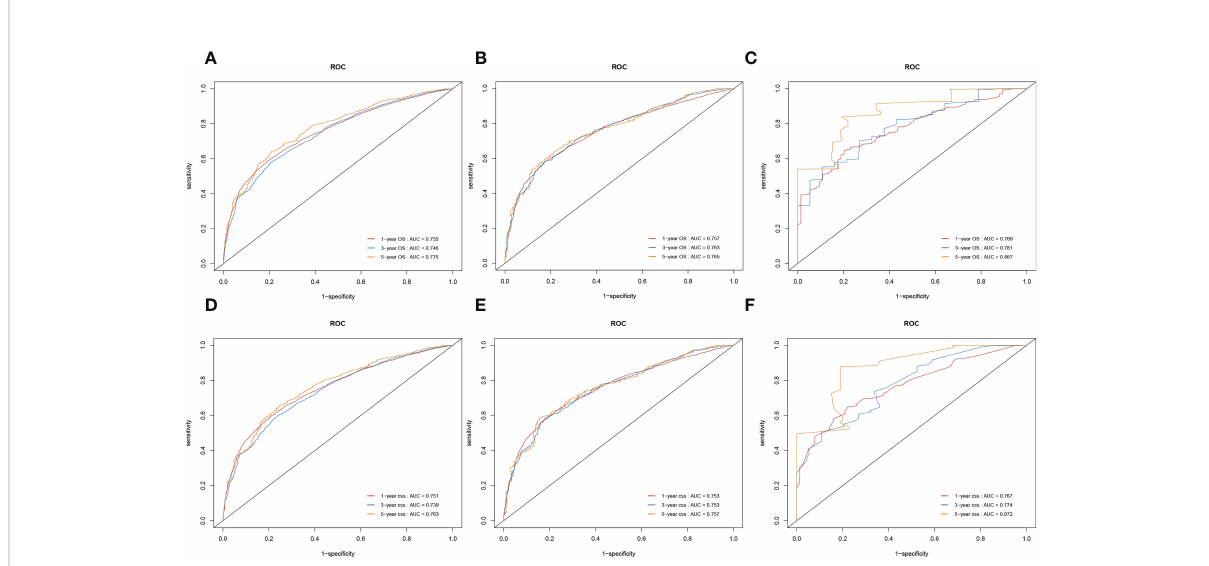
FIGURE 7 Nomograms of time-dependent receiver operating characteristic (ROC) curves for the overall survival (OS) and cancer-speci fi c survival (CSS) prediction of patients with lung cancer with bone metastasis (LCBM). (A – C) The training, internal validation, and external validation cohorts for the OS. (D – F) The training, internal validation, and external validation cohorts for the CSS.